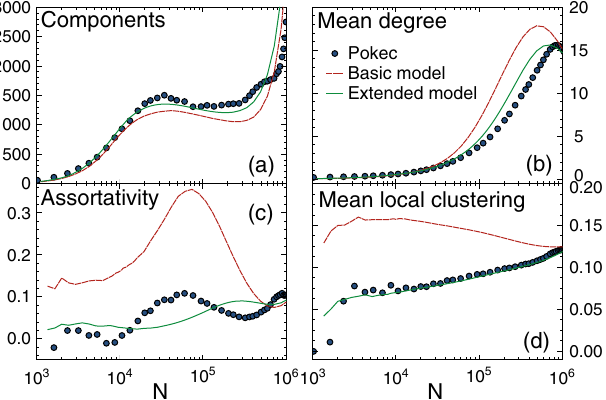
FIG. 5. Topological evolution of the empiric network (blue circles), the basic model (red dashed lines), and the extended model (green lines). (a) Evolution of the number of components of size s > 1 . (b) The evolution of the mean degree shows a densification of the network. (c) The assortativity coefficient as defined in Ref. [52]. (d) The evolution of the mean local clustering coefficient (of nodes with k > 1 ) exhibits an essential difference between the basic model (red dashed line) and the extended model with η ¼ − 0 . 65 (green